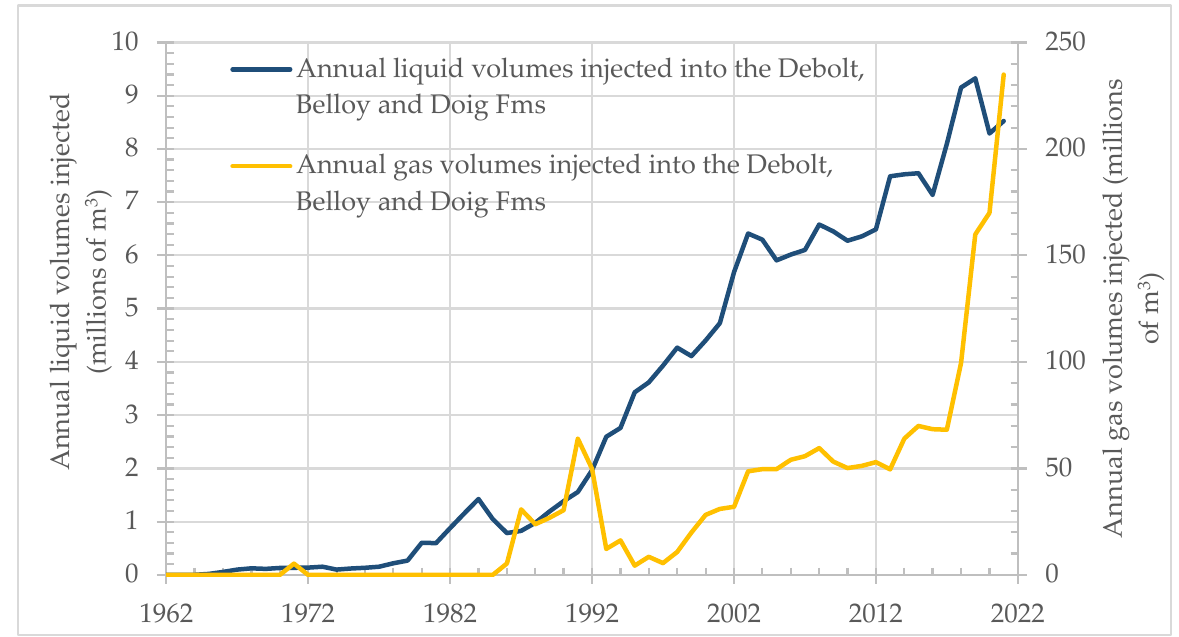
Figure 4. Annual fluid volumes (measured at surface conditions) injected into three regional (i.e., limited geographic extent) formations in the Alberta Basin.